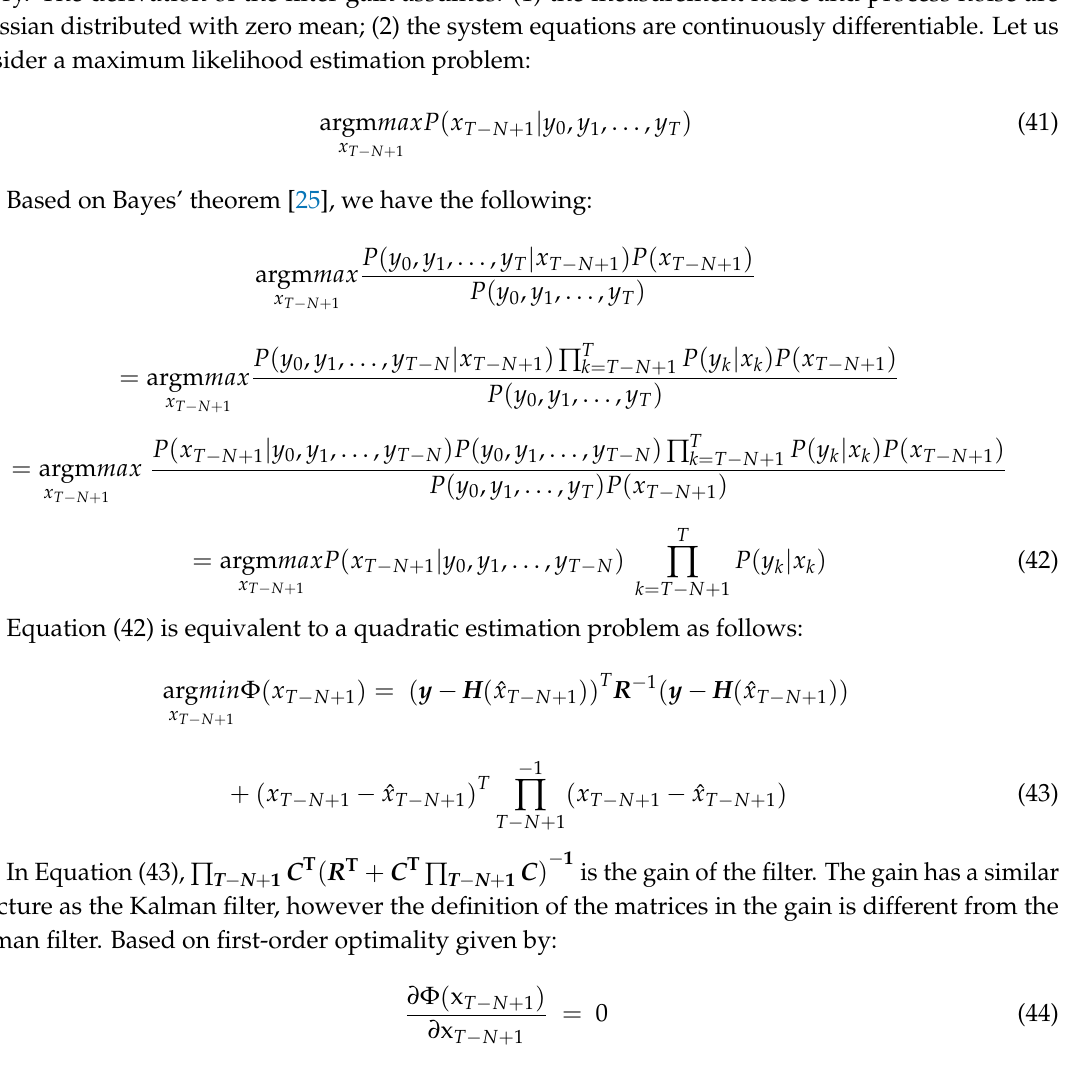
Figure 5. ( a ) Conventional sequential estimation scheme, ( b ) moving-window state filter.